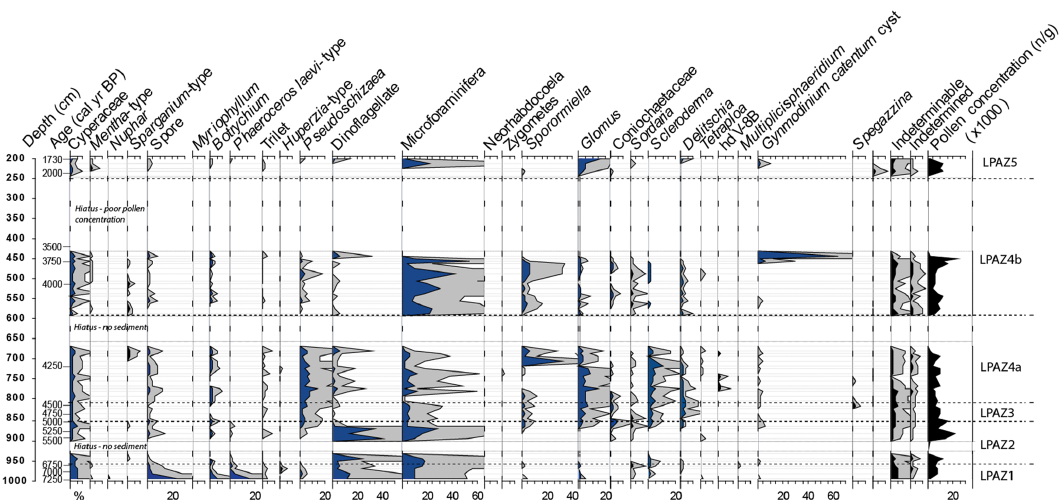
Figure 6. Burmarrad pollen percentage diagram versus depth: aquatic/wetland taxa and NPPs. The pollen percentages are calculated us- ing the pollen sum of all terrestrial pollen counted; it excludes Cyperaceae and other aquatic/hygrophilous species, NPPs, and undeter- mined/indeterminable grains.